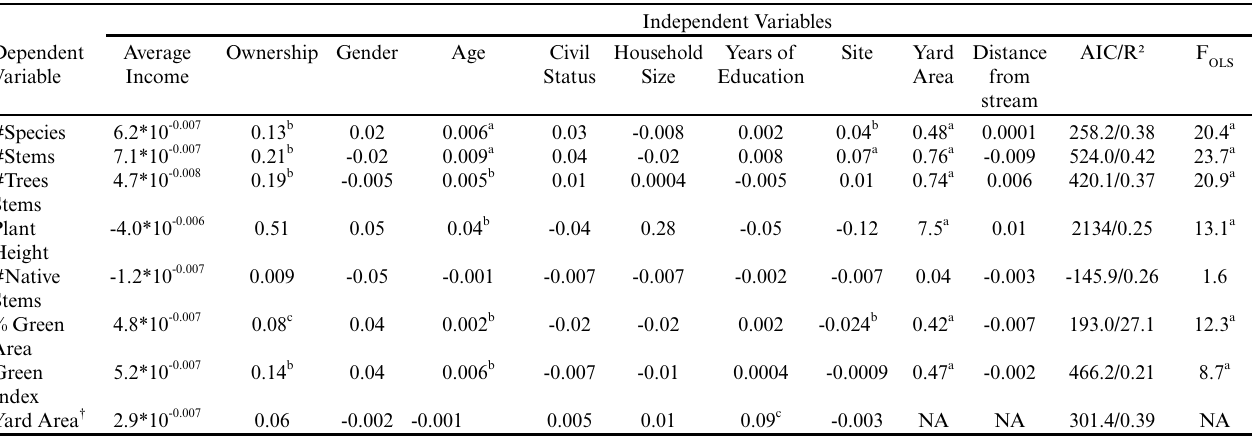
Table 2 . Regression coefficients for coefficients for ordinary least squares (OLS) and spatial-lag (SLR) multiple regression using yard vegetation variables as a function of household socioeconomic and physical variables. Spatial regression models were applied following significant tests for spatial autocorrelation in the data (as indicated by significant Moran’s I values). The log (N+1) transformation was used for all count variables and for yard area while the arcsine was used for the percentage of green area. Households with missing data were excluded from this analysis yielding a total N = 363.